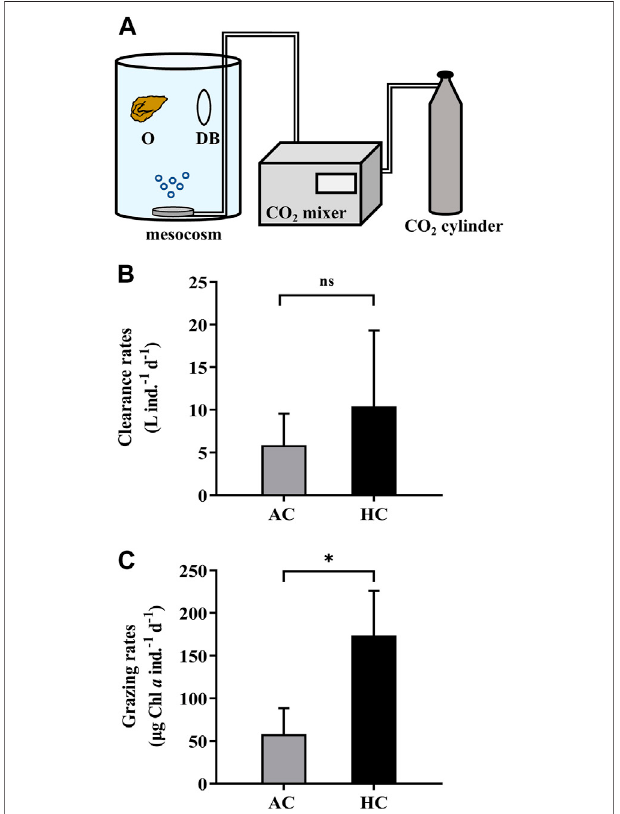
FIGURE 5 | The dialysis bags with phytoplankton and zooplankton inside were employed in the mesocosms (3000 L) to determine the grazing ratesbyoysters (A) .Theletter “ O ” representsoysters,and “ DB ” dialysisbags. The clearance rates (B) and grazing rates (C) of the oysters Crassostrea angulata on natural phytoplankton assemblages in the AC (ambient p CO 2 , 410 μ atm, grey bars) and HC (high p CO 2 , 1,000 μ atm, black bars) mesocosms. Data are the means ± SD, n = 4 (4 independent mesocosms). Independent samples t-test was used to test the difference in the clearance rates and grazing rates of C. angulate between p CO 2 treatments. Asterisk indicates the signi fi cant difference at p < 0.05 level, and ns stands for non- signi fi cant